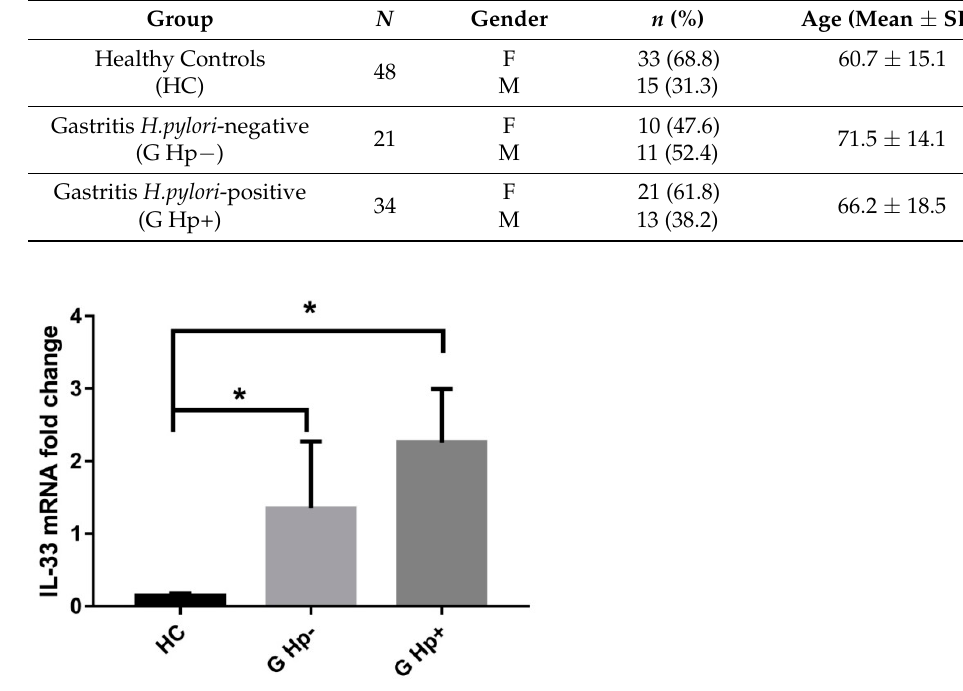
Figure 1. Gastric IL-33 is elevated in patients with a diagnosis of gastritis and even more in H.pylori - positive diagnosis. RealTime PCR in gastric biopsies showed a correlation between gastritis and H.pylori -positive gastritis. Data are shown as mean ± SD. HC: healthy controls; GHp − : gastritis H.pylori -negative; GHp+: gastritis H.pylori -positive. * p < 0.05. Table 1. Demographic of patients enrolled for biopsy specimen